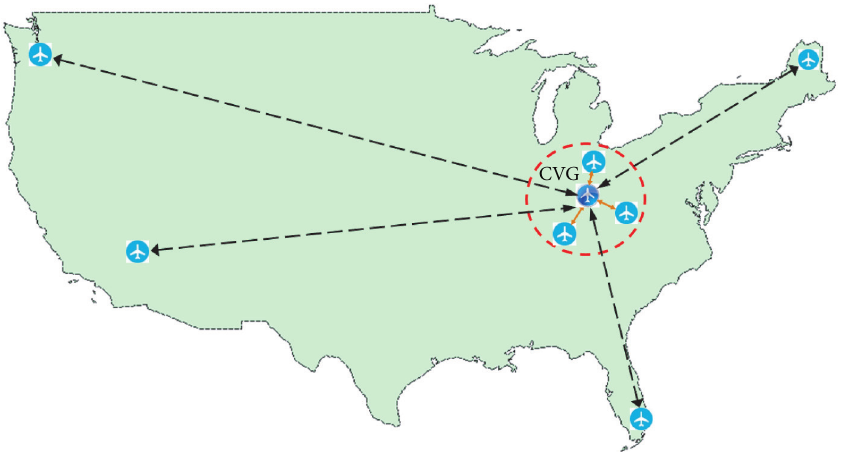
Figure 1: Schematic diagram of the airport association relationship, where the red dotted circle represents the local neighborhood centered on Cincinnati International Airport (three-letter code CVG). The black double arrow represents the airport connected to CVG by